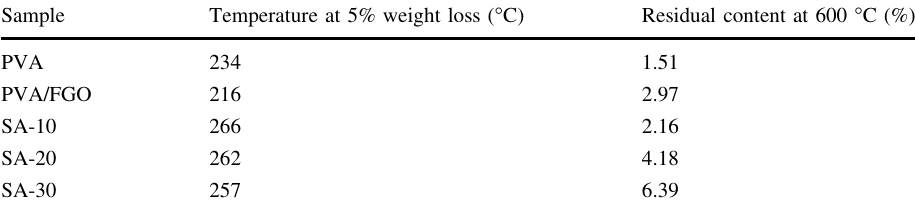
Table 1 TGA data of neat PVA, PVA/FGO and coated PVA